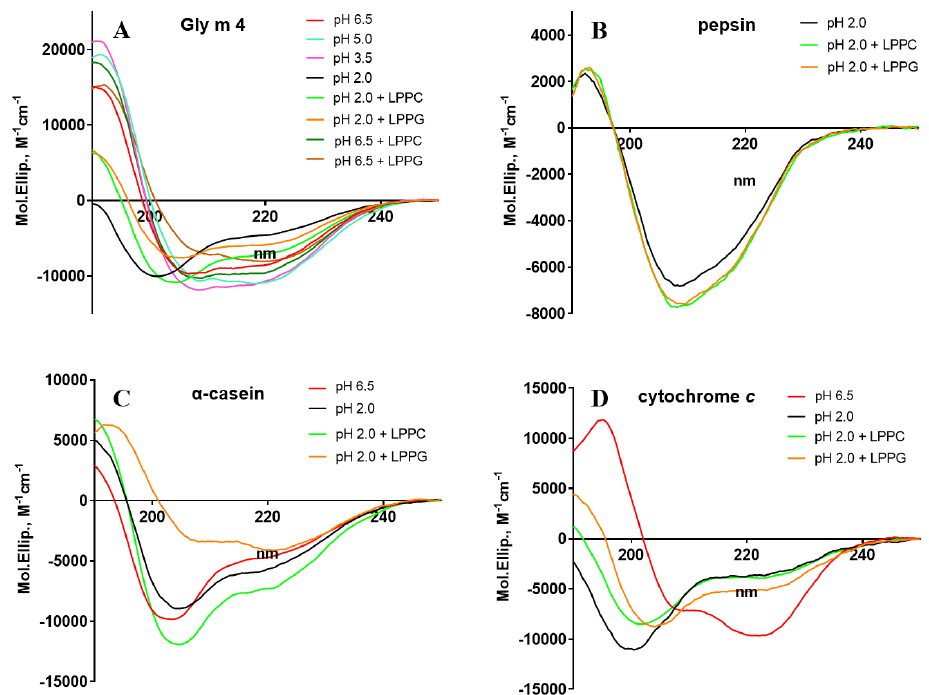
Figure 2. The effects of different pH and lysolipids (at final concentration of 0.2 mM) on the secondary structure of Gly m 4 ( A ), pepsin ( B ), α -casein ( C ), and cytochrome c ( D ).